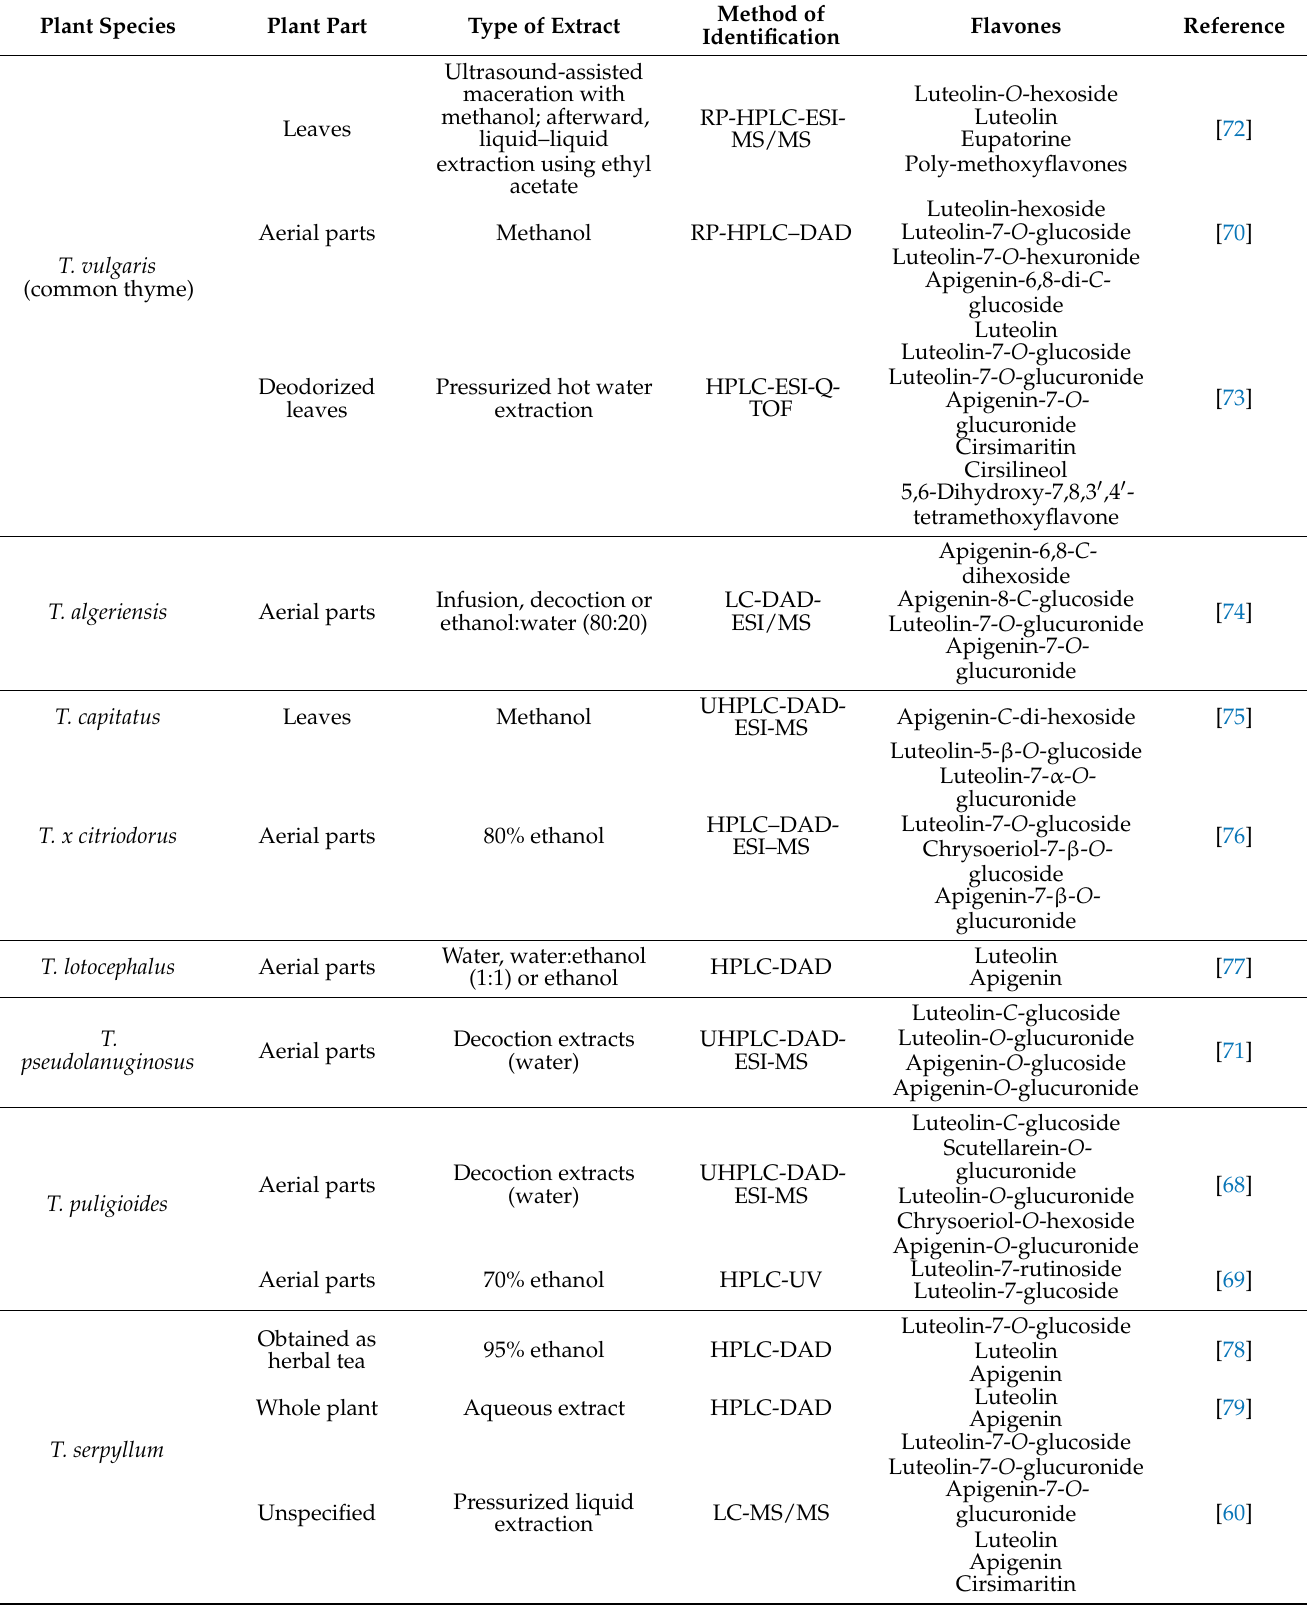
Table 2. Flavones identified in several Thymus